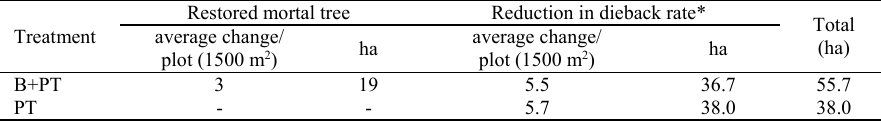
Table 5: Re-growth of dried tree and reduction in dieback rate through semi-circular bund in the study area (Kalezard forest, Kermanshah, Iran) Treatment